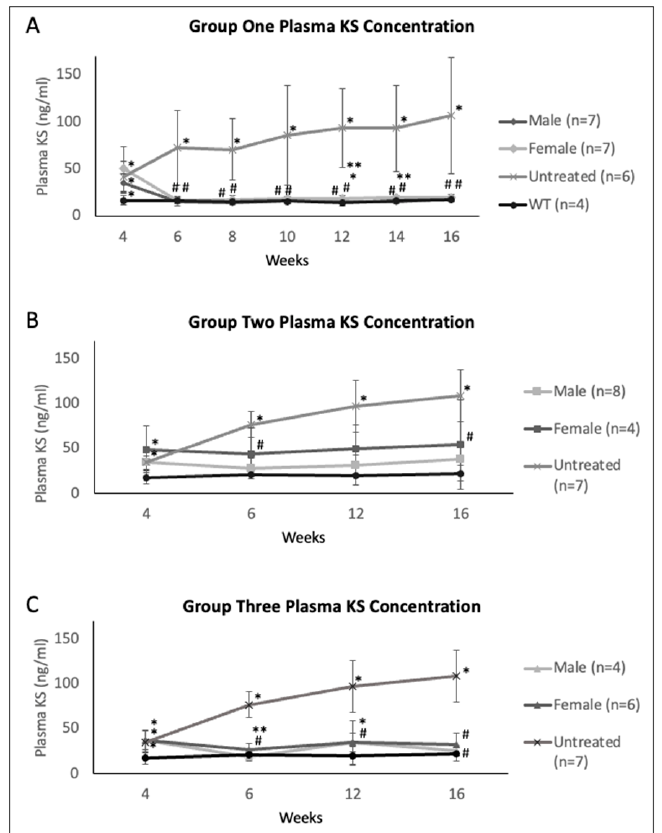
improved KS levels compared to the untreated cohort. Female mice had higher KS levels than male mice from 6 through 16 weeks old (Figure 3B). In Group Three, male mice had lower KS levels than female mice and achieved normalized KS values between 6 weeks (6 weeks, female to male, 44.4 ng/mL to 27.7 ng/mL; 12 weeks, female to male, 49.1 ng/mL to 30.8 ng/mL) and 16 weeks (female to male, 54.0 ng/mL to 37.7 ng/mL). Female mice had decreased but not normalized KS values post-treatment throughout the study (Figure 3C).